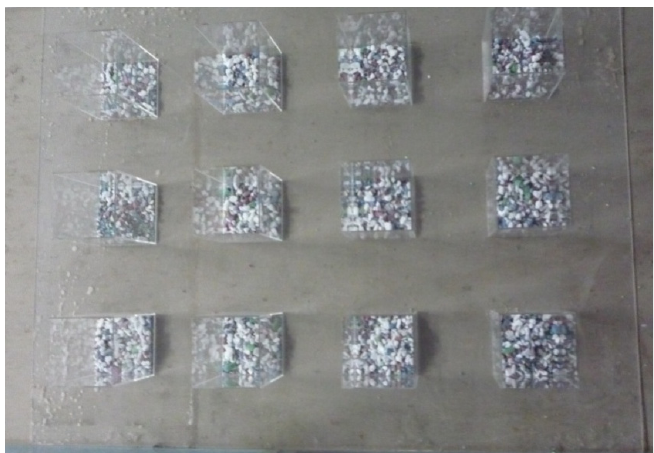
Figure 3. Building model represented by plastic